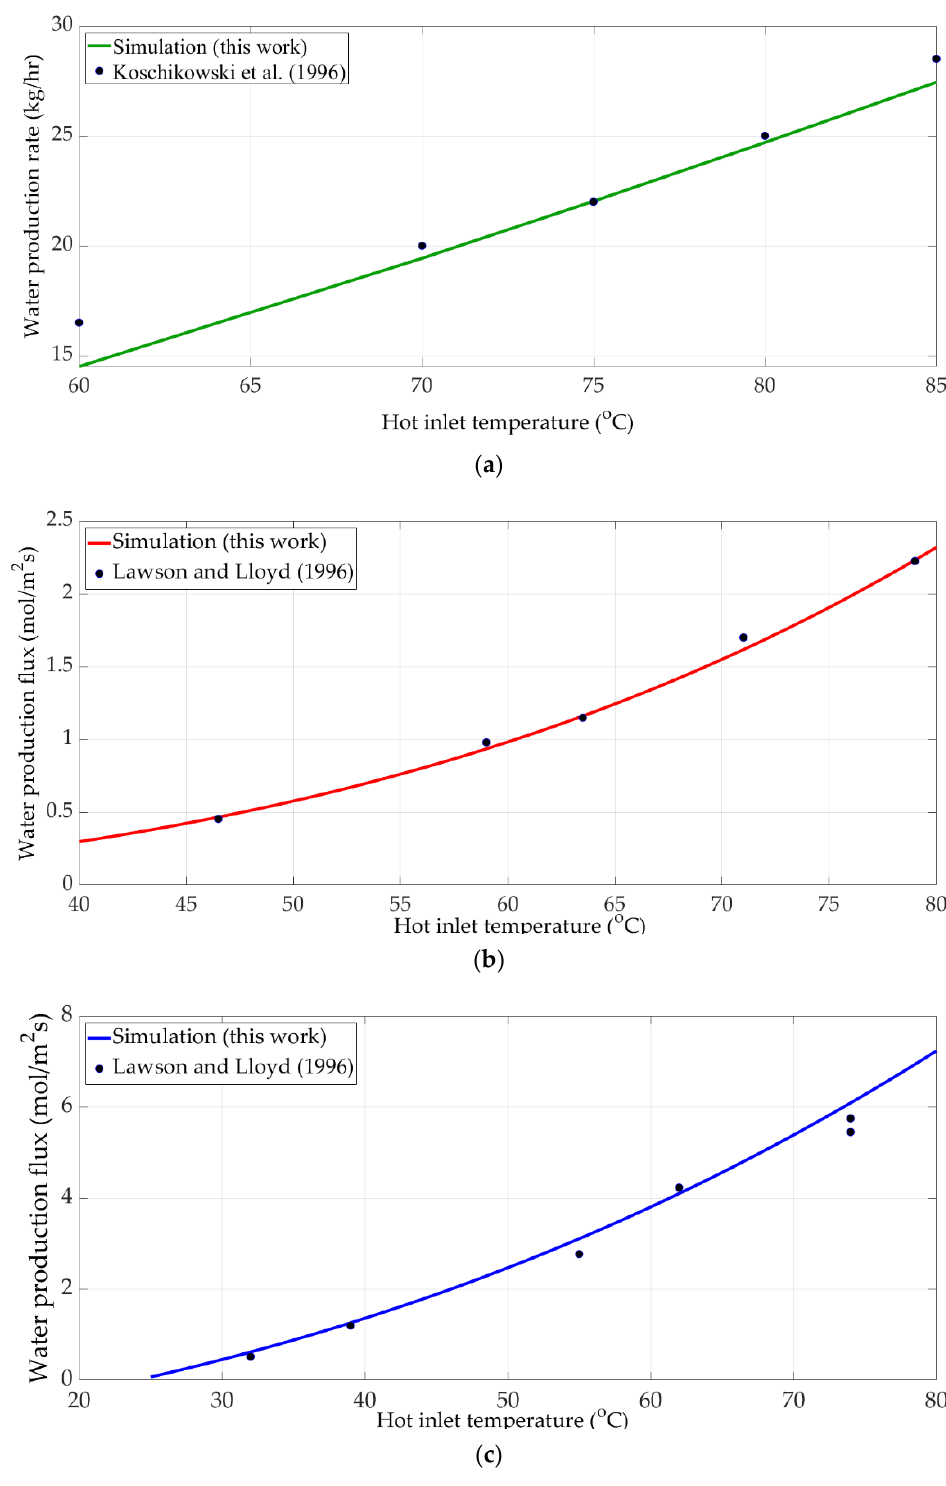
Figure 3. Model validation using experimental data from literature for ( a ) AGMD, ( b ) DCMD, ( c ) VMD modules.